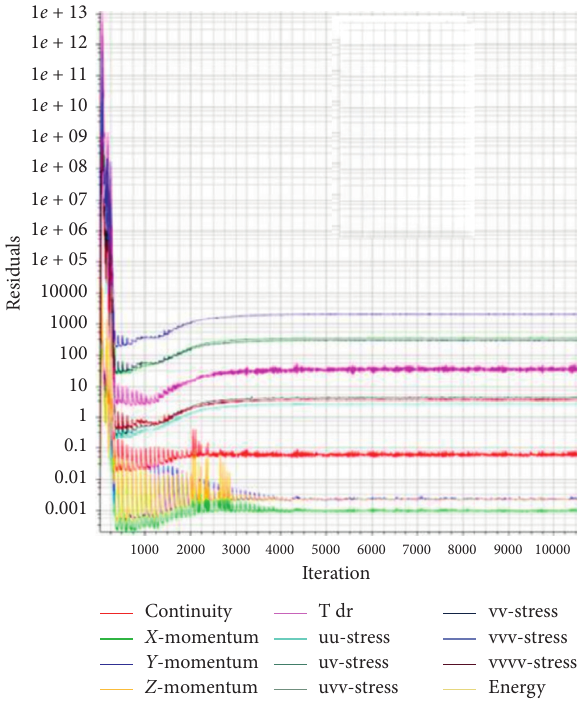
Figure 2: Residual function plot.